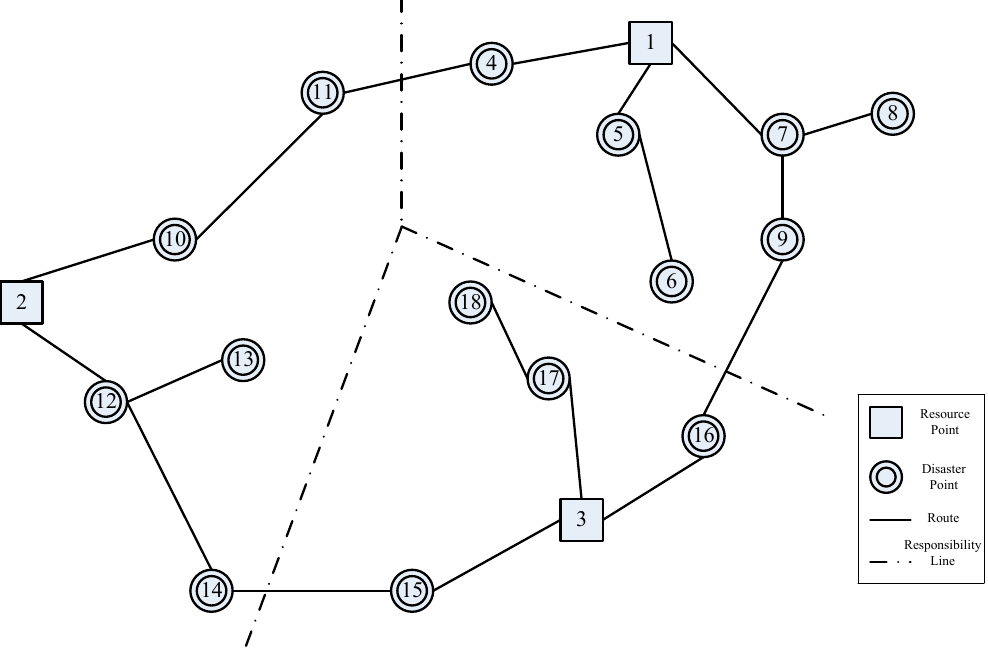
Figure 2. Diagram of the responsibility areas of Case 1.